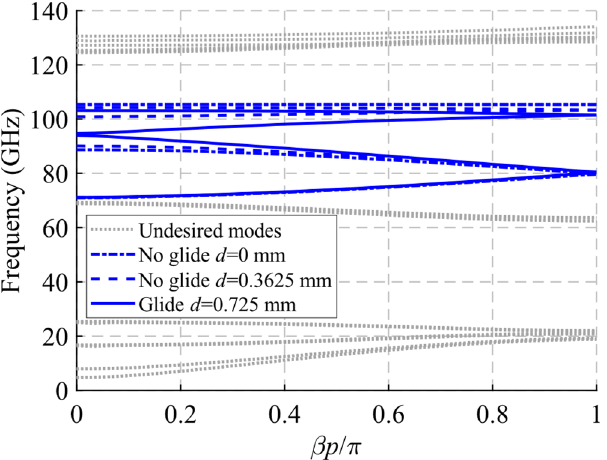
Figure 25. Dispersion diagram of the double periodic final unit cell for different stages of break of symmetry.